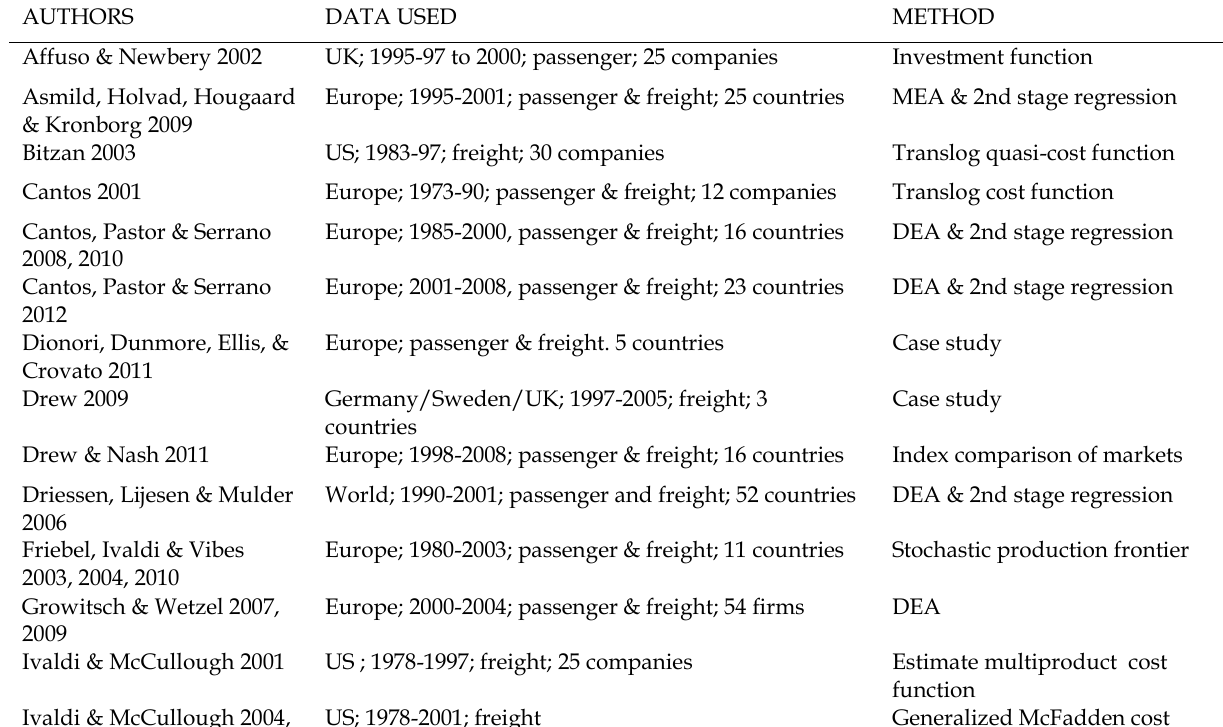
Table A1. Summary of studies on rail vertical integration – methodologies and data used